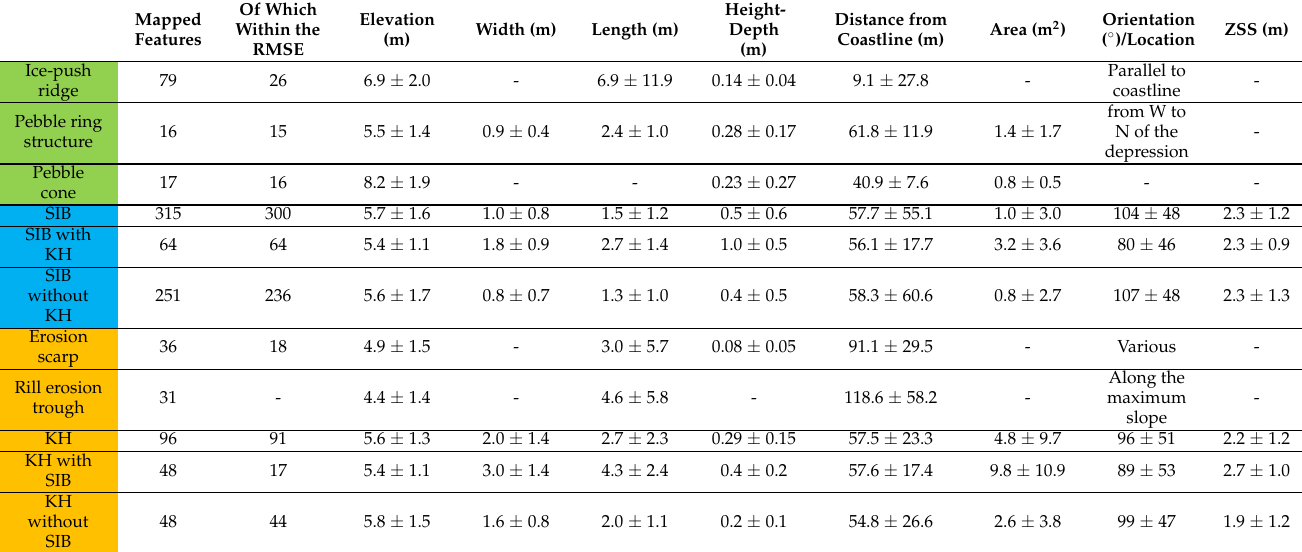
Table 2. Characteristics of the geomorphological features mapped on the beach. The statistics refer to medians ± standard deviations of the mapped features morphology/location. Green background color refers to aggradational features, blue to ice blocks and orange to erosion